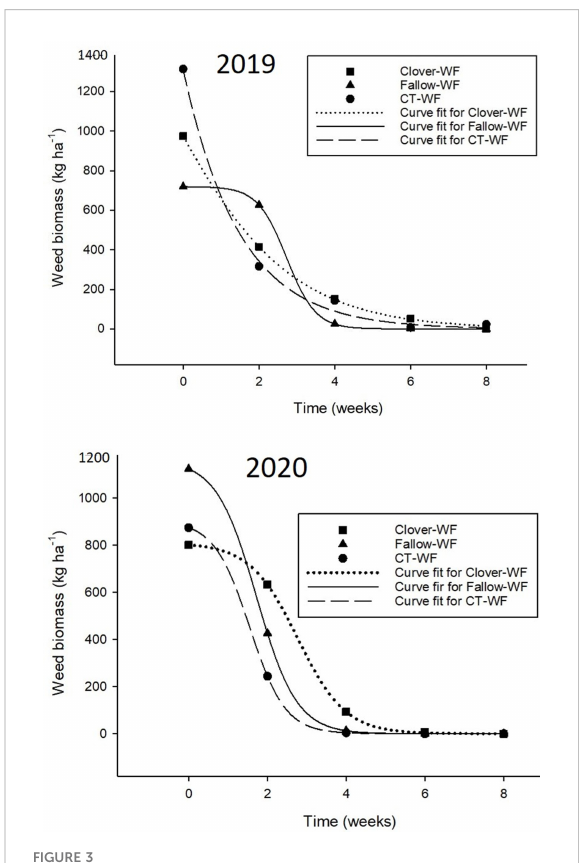
FIGURE 3 Weed biomass as a function of critical weed-free period CWFP for each of the conservation tillage following a crimson clover cover crop (CT + CC), conservation tillage following winter fallow (CT + WF), and conventional tillage without a cover crop (CVT) treatment in 2019 and 2020 experimental treatments. Parameters of the model are presented in Table 5. WF depicted weed-free; Fallow referred to winter fallow (CT + WF), clover referred to cover crop (CT + CC), and CT depicted conventional tillage (CVT).